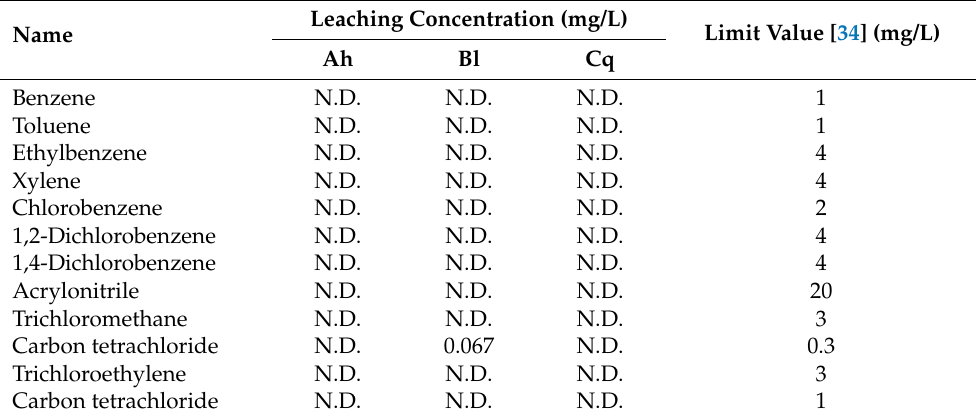
Table 3. Determination of volatile organic compounds in excess sludge